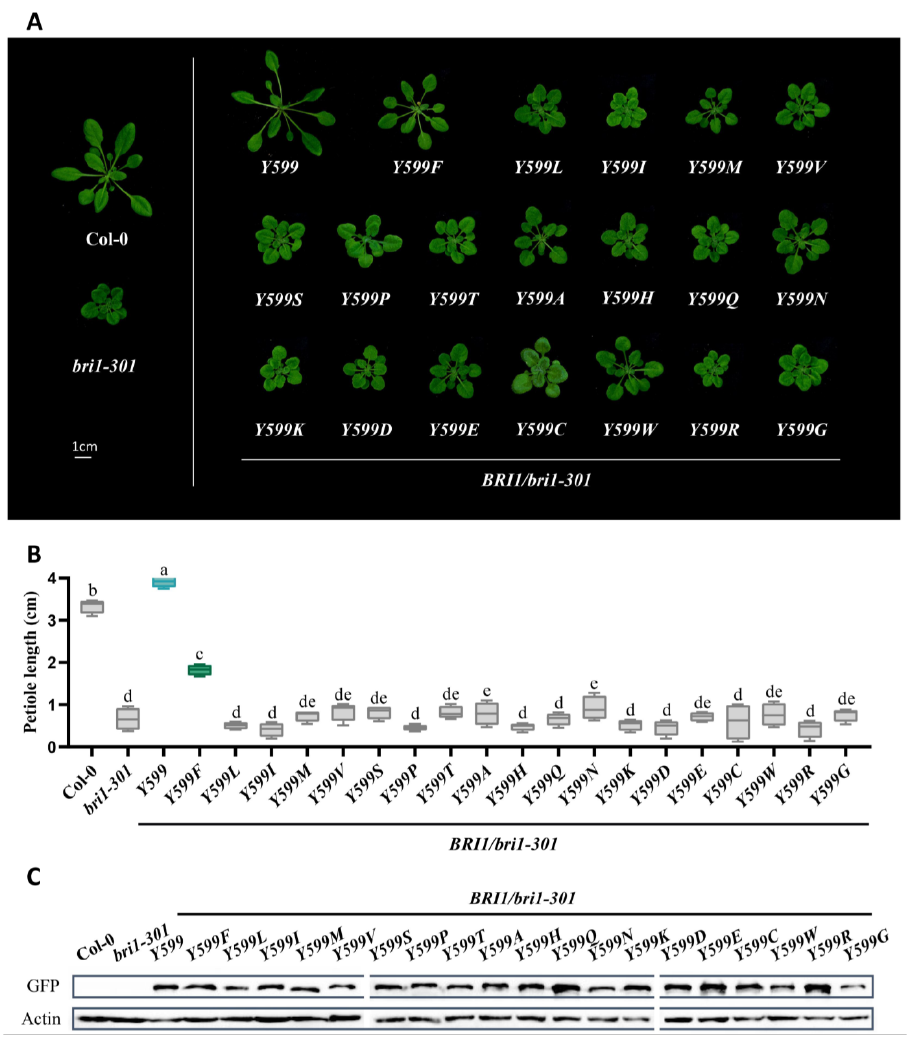
Figure 4. The tyrosine of residue 599 specifies the essential BR receptor BRI1 from BRL1/3. ( A ) Phe- notypic analysis of 4-week-old seedlings of wild-type Col-0, bri1-301 , and transgenic plants with mutated receptors expressed in bri1-301 . Scale bar = 1 cm. ( B ) Analysis of petiole length represented as the means ± SD. The blue box highlights Tyrosine599, the green indicates phenylalanine fixed in BRL1/3, and the grey represents the remaining amino acids. Different letters indicate significant differences ( n = 15, p < 0.0001, one-way ANOVA with a Tukey’s test). ( C ) Protein expression com- parison of mutated receptors tagged with GFP in transgenic plants. An anti-GFP antibody was used to quantify the expression level.